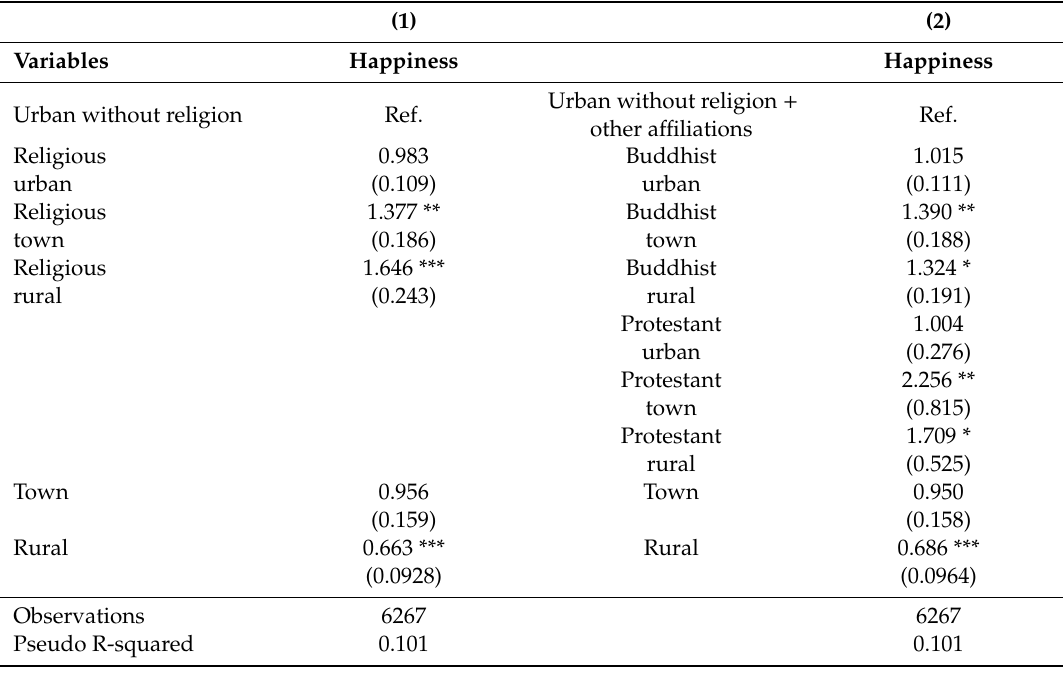
Table 4. The association between happiness and religious a ffi liations among urban, town, or rural residents (ordered logistic model, odds ratios reported).